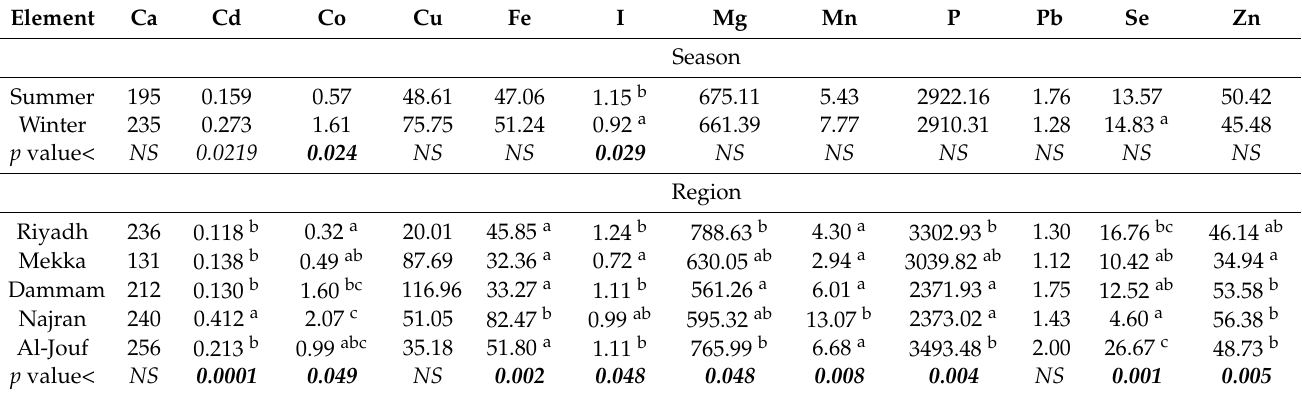
Table 6. Mean values of minerals in camel meat according to region and season [ µ g/g wet weight].